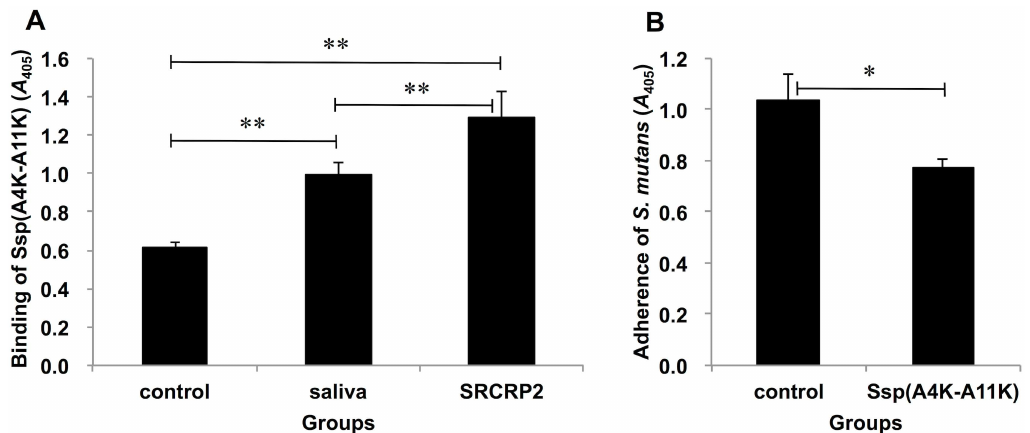
Fig 2. Effect of Ssp(A4K-A11K) on S . mutans adherence to SRCRP2. (A) Bindingof Ssp(A4K-A11K) to SRCRP2. (B) Inhibitionby Ssp(A4K-A11K) of S . mutans adherenceto SRCRP2. Data are expressedas mean absorbance at 405 nm ± SDs of three independentexperiments with technicalreplicates[control: (A) BSA or (B) DW; * P < 0.05, ** P < 0.01].